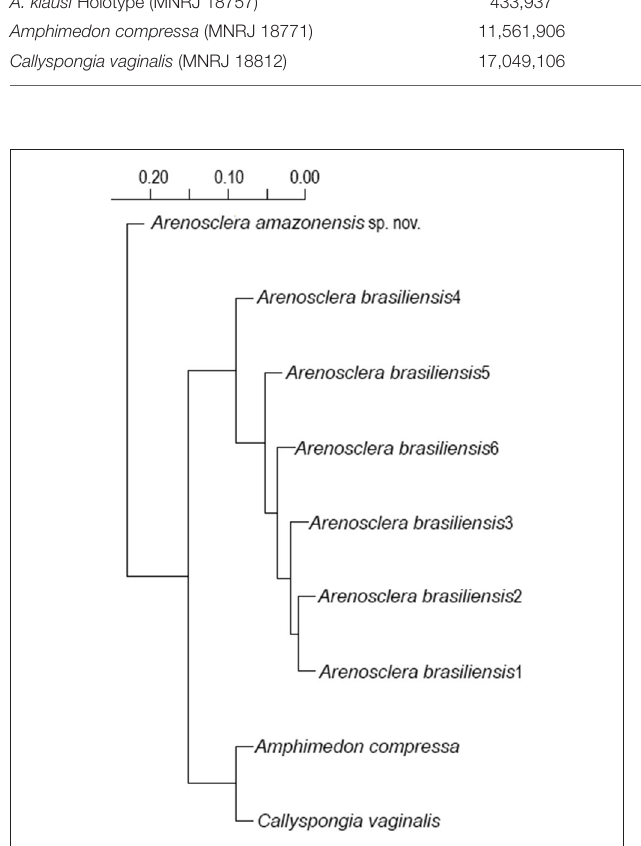
FIGURE 2 | Hierarchical clustering of metagenomes from dinucleotide relative abundances. Metagenomes are labeled according to their sponge source.